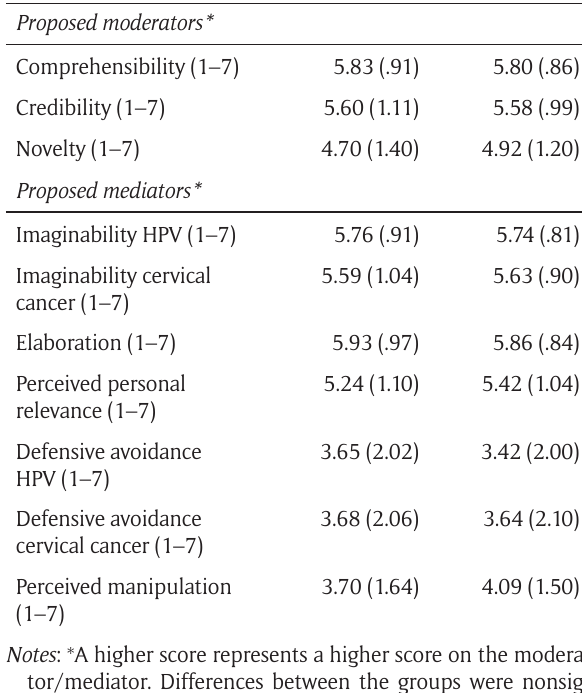
Table 4: Mean scores ( SD ) on moderators and mediators of those who did versus those who did not receive statis- tical risk information ( N =